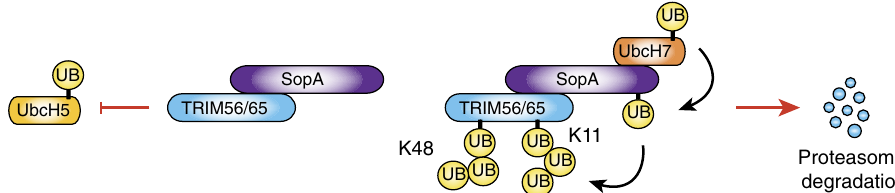
Figure 8 | Model for dual SopA-mediated targeting of TRIM56 and TRIM65. Binding of SopA to the RING domains of TRIM56 and TRIM65 impedes TRIM E3 Ub ligase activity by occluding the RING-E2 interaction surface (left panel). The SopA HECT ligase activity deposits degradative ubiquitin chains linked via K48 and K11 on TRIM56 and TRIM65, resulting in their proteasomal degradation during Salmonella infection (right